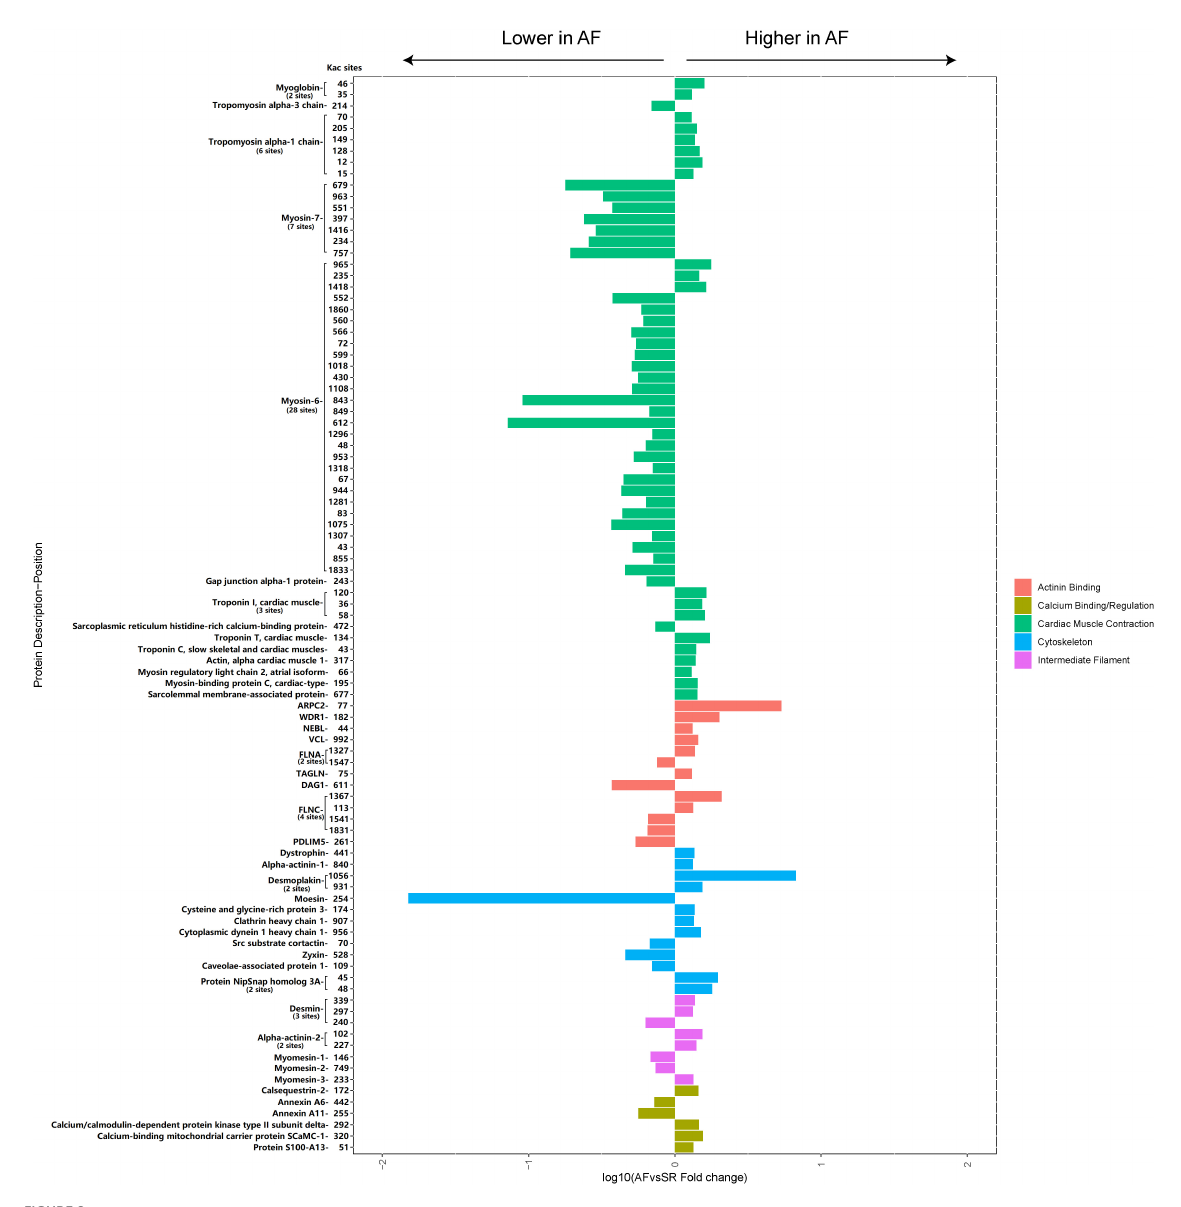
FIGURE8 Histogram bar and comparison of the AF/SR differentially expressed cellular contraction- and structure-related acetylated proteins and sites in LAA tissues. AF, atrial fibrillation; SR, sinus rhythm; LAA, left atrial